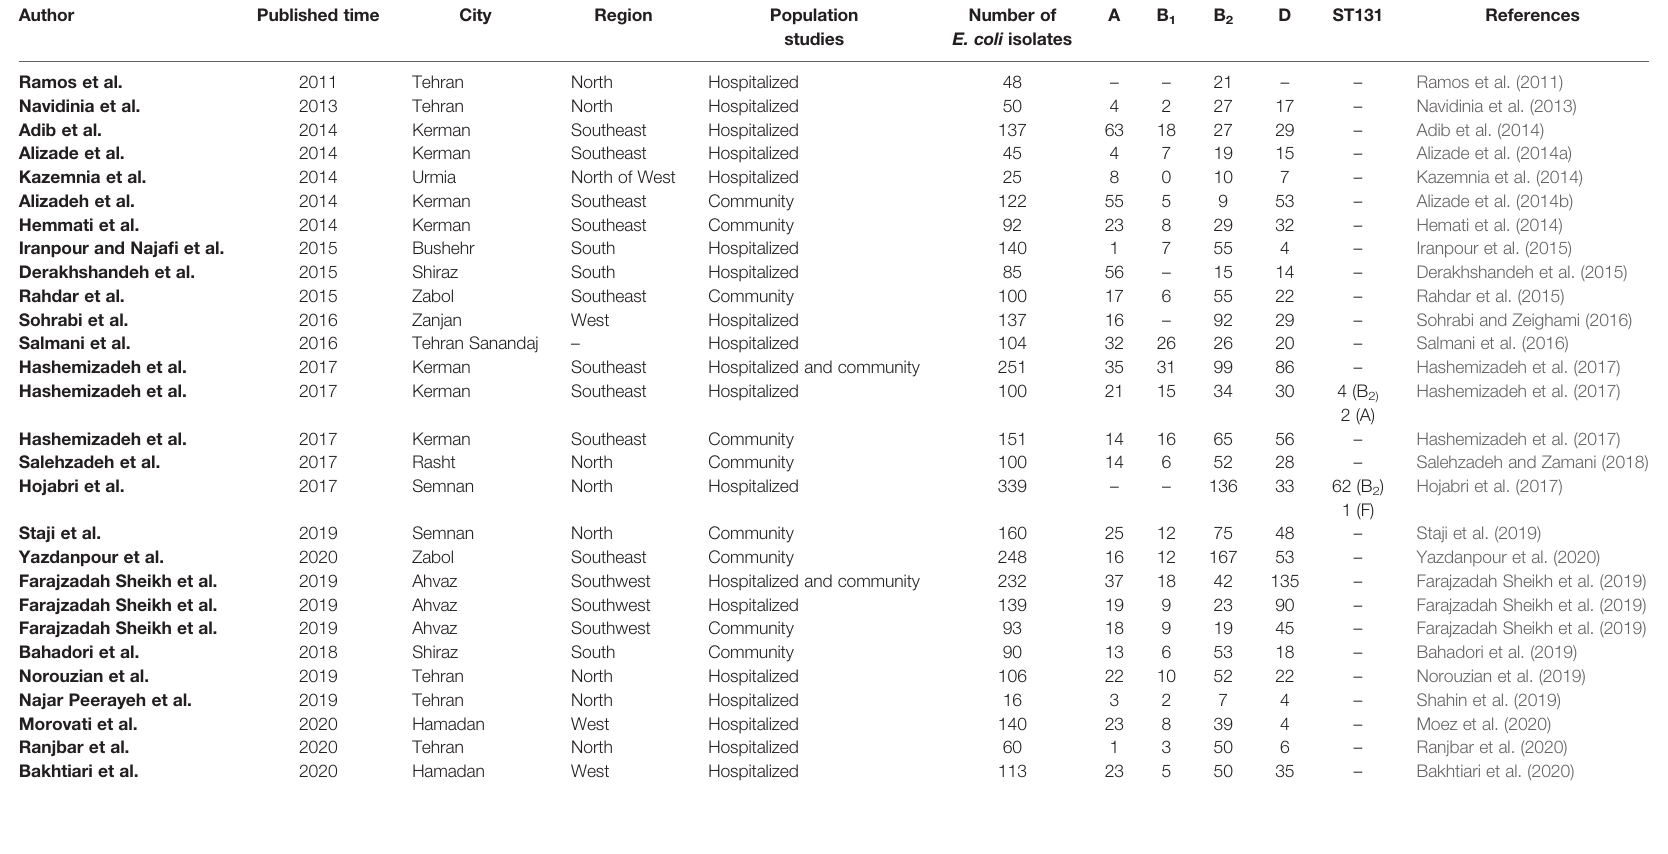
TABLE 1 | The main characteristics of studies included in the